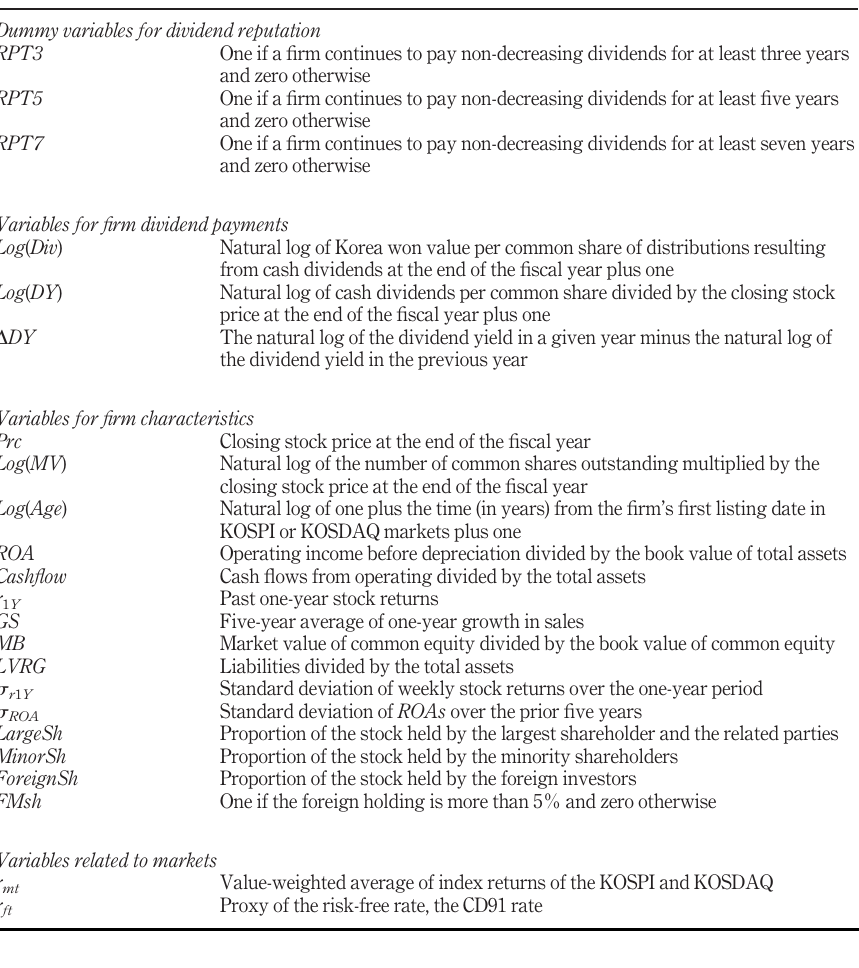
Table 1. Variable de fi